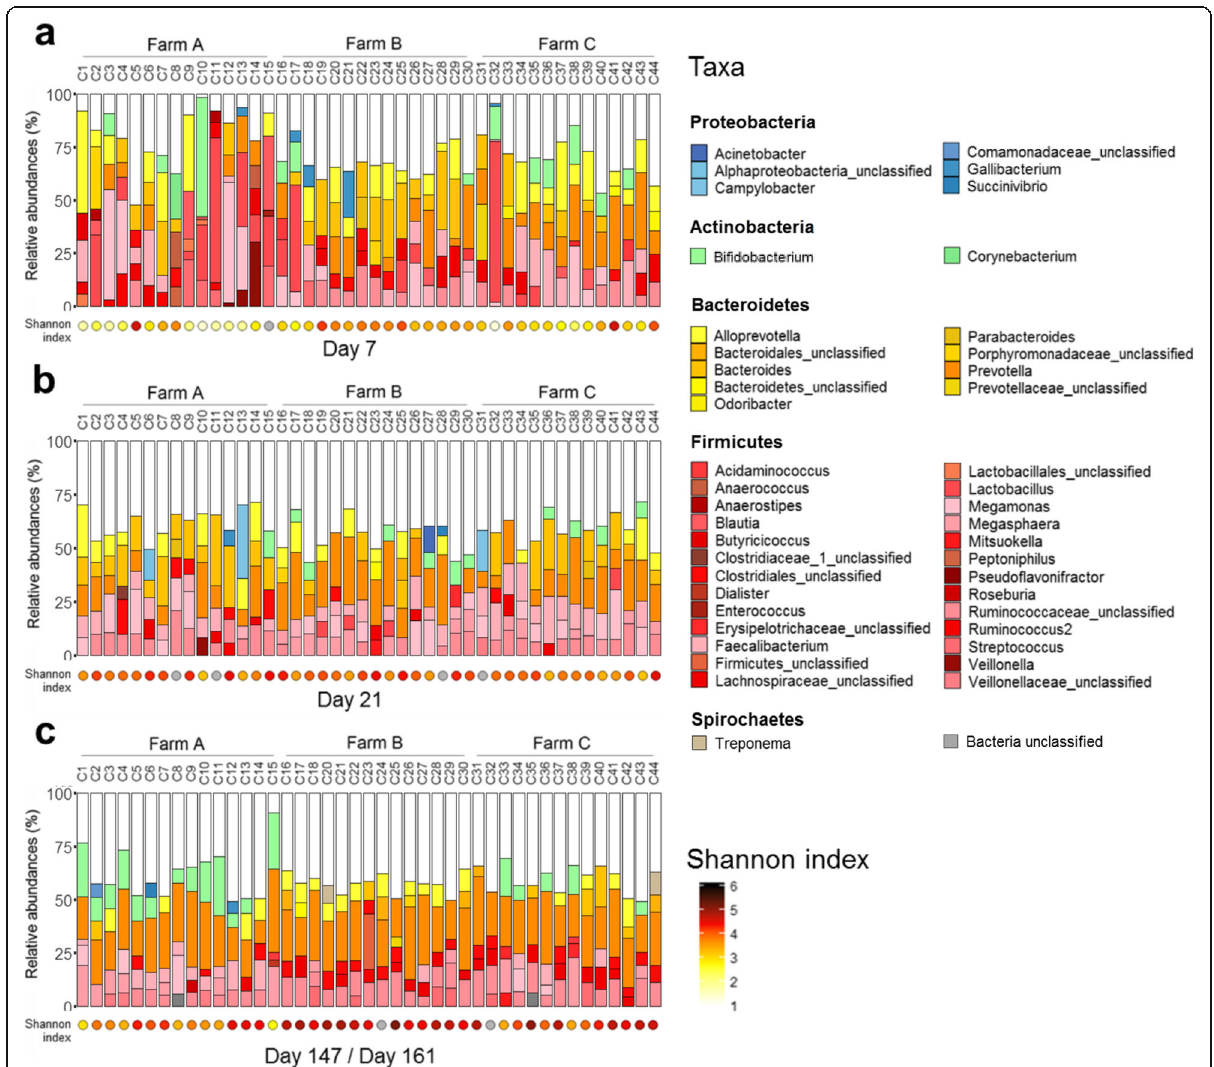
Fig. 4 Individual microbiota composition at the genus level at the first and last month of fattening. Relative abundance of the five most abundant taxa at the genus level for all calves for the ( a ) first sampling (day 7), ( b ) second sampling (day 21), and ( c ) last sampling (day 161 for farms A and B and day 147 for farm C). Other detected taxa are depicted in white. Calf IDs are given at the top of the panels and are ordered according to farm. The color scale of the dots beneath the bar graphs represents the distribution of the Shannon index values. Grey dots indicate samples for which no index was computed because the number of sequences was lower than the rarefaction threshold. The color key refers to the phylum of each taxa and each palette was built to maximize the distinctiveness between